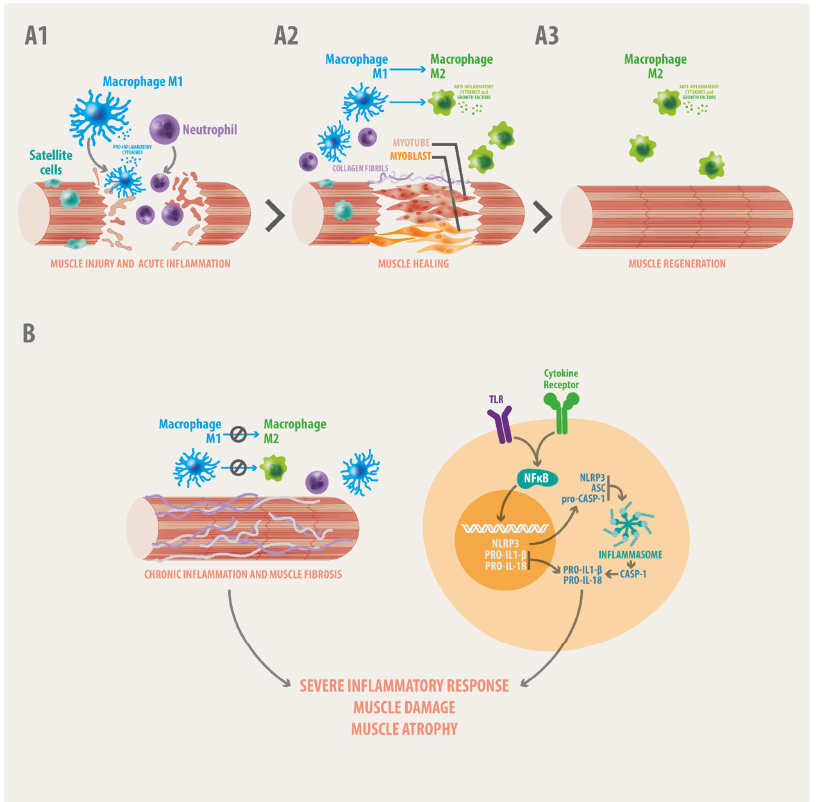
Figure 1. Inflammation in skeletal muscle healing and degeneration. ( A1 – A3 ) Upon muscle injury immune cells infiltrate, monocytes become macrophages with a proinflammatory M1-phenotype that release proinflammatory cytokines and growth factors promoting satellite cell proliferation ( A1 ), myotube formation and muscle healing ( A2 ) The transition from M1 to M2 pro-resolutive macrophages favors muscle regeneration ( A3 ). ( B ) When these processes are deregulated the M1 to M2 transition is suppressed and inflammation becomes chronic, producing accumulation of fibrotic tissue and muscle dysfunction and atrophy. Proinflammatory cytokines bind to their receptors in inflammatory cells as well as in muscle cells, promoting the activation of the NFKB signaling, assembly of the NLRP3 inflammasome, activation of caspase-1 and cleavage of the immature forms of the IL1 family (pro-IL1), thus enhancing inflammation and potentially contributing to muscle damage. Damage signals also activate toll-like receptors (TLRs), promoting the same